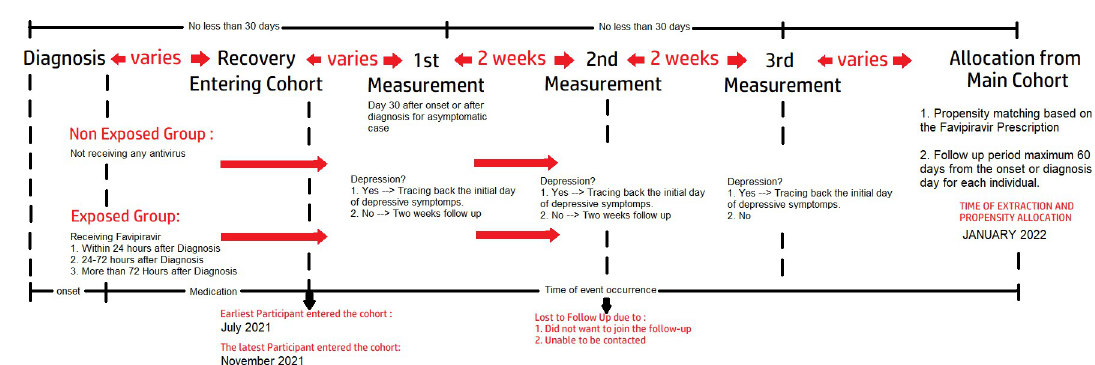
Fig 1. Timeline of the cohort. Time of participant recruitment and allocation to create a quasi-experimental